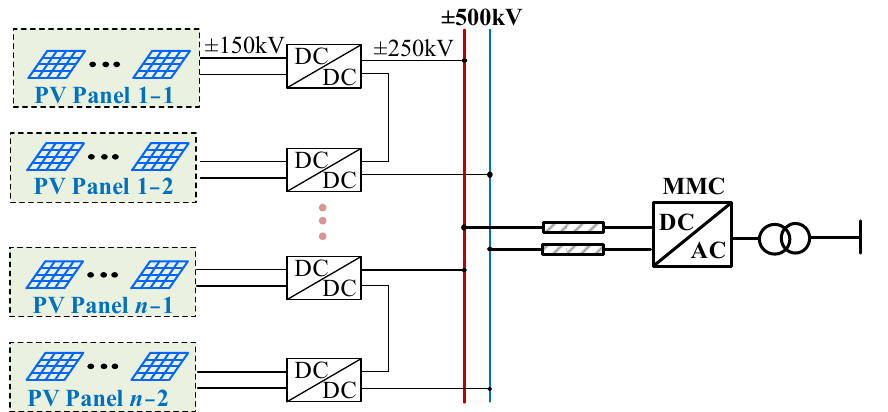
Figure 1. Multi-voltage level DC grid with distributed renewable Figure 1. Multi ‐ voltage level DC grid with distributed renewable energy.